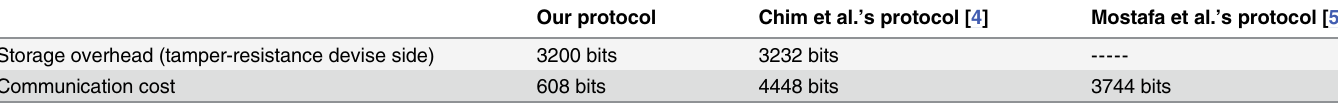
Table 3. Communication costs and storage overhead comparison between our protocol and